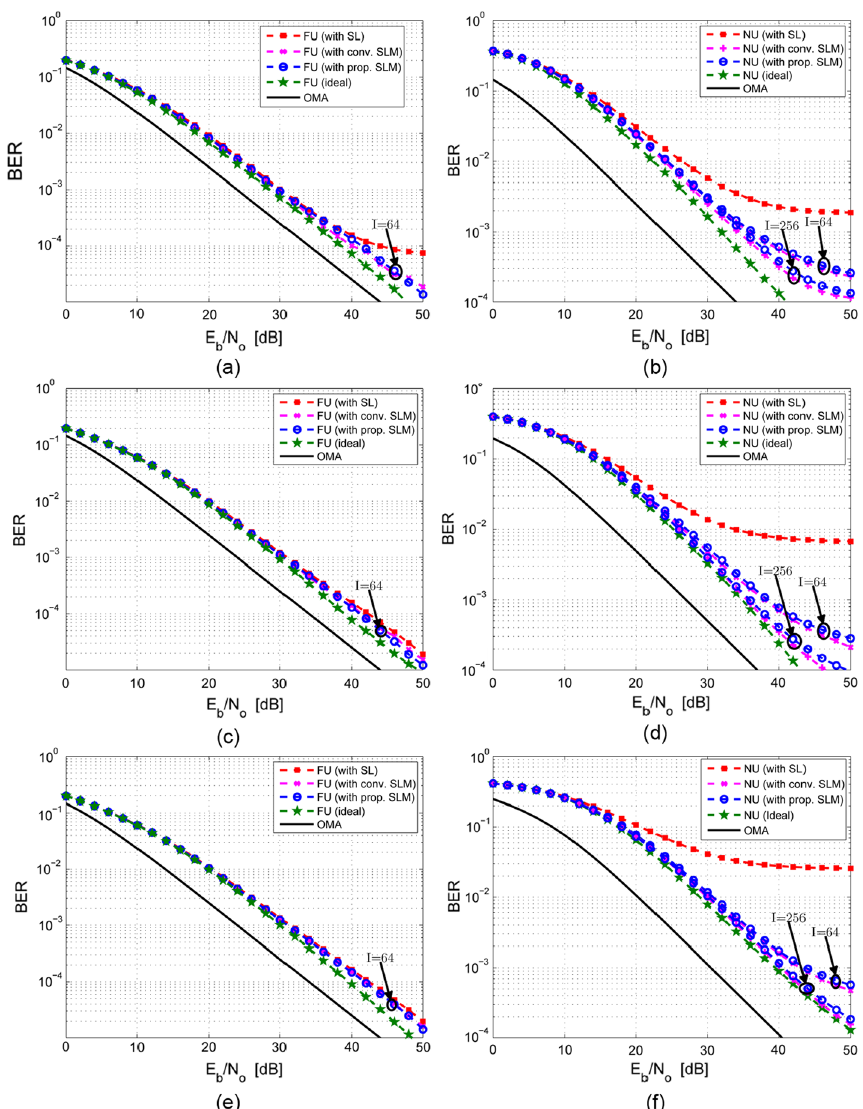
Fig. 10 BER versus E b / N o , for both FU and NU, before and after usage of conventional and proposed SLM in the presence of nonlinear distortion for three scenarios. a FU in the (4-QAM/4-QAM) scenario, b NU in the (4-QAM/4-QAM) scenario, c FU in the (4-QAM/16-QAM) scenario, d NU in the (4-QAM/16-QAM) scenario, e FU in the (4-QAM/64-QAM) scenario, and f NU in the (4-QAM/64-QAM) scenario. Ideal NOMA and OMA are shown in all subfigures as a reference. The effect of increasing I from 64 up to 256 on the NU’s BER is also investigated in b , d , and